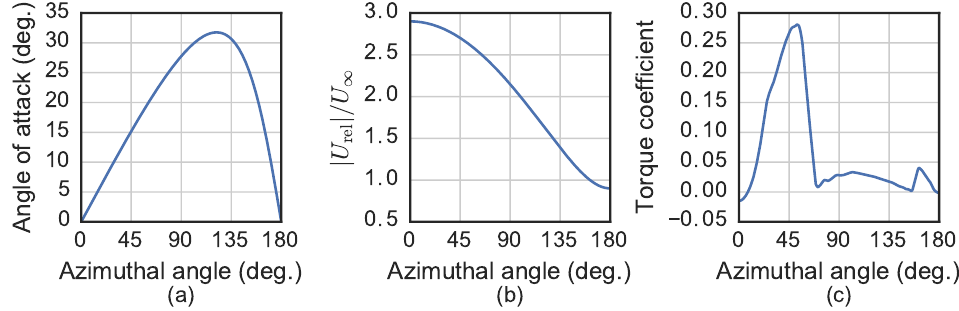
Figure 8. Geometric angle of attack ( a ), relative velocity ( b ), and torque coefficient ( c ) calculated with a NACA 0020 foil operating at λ =